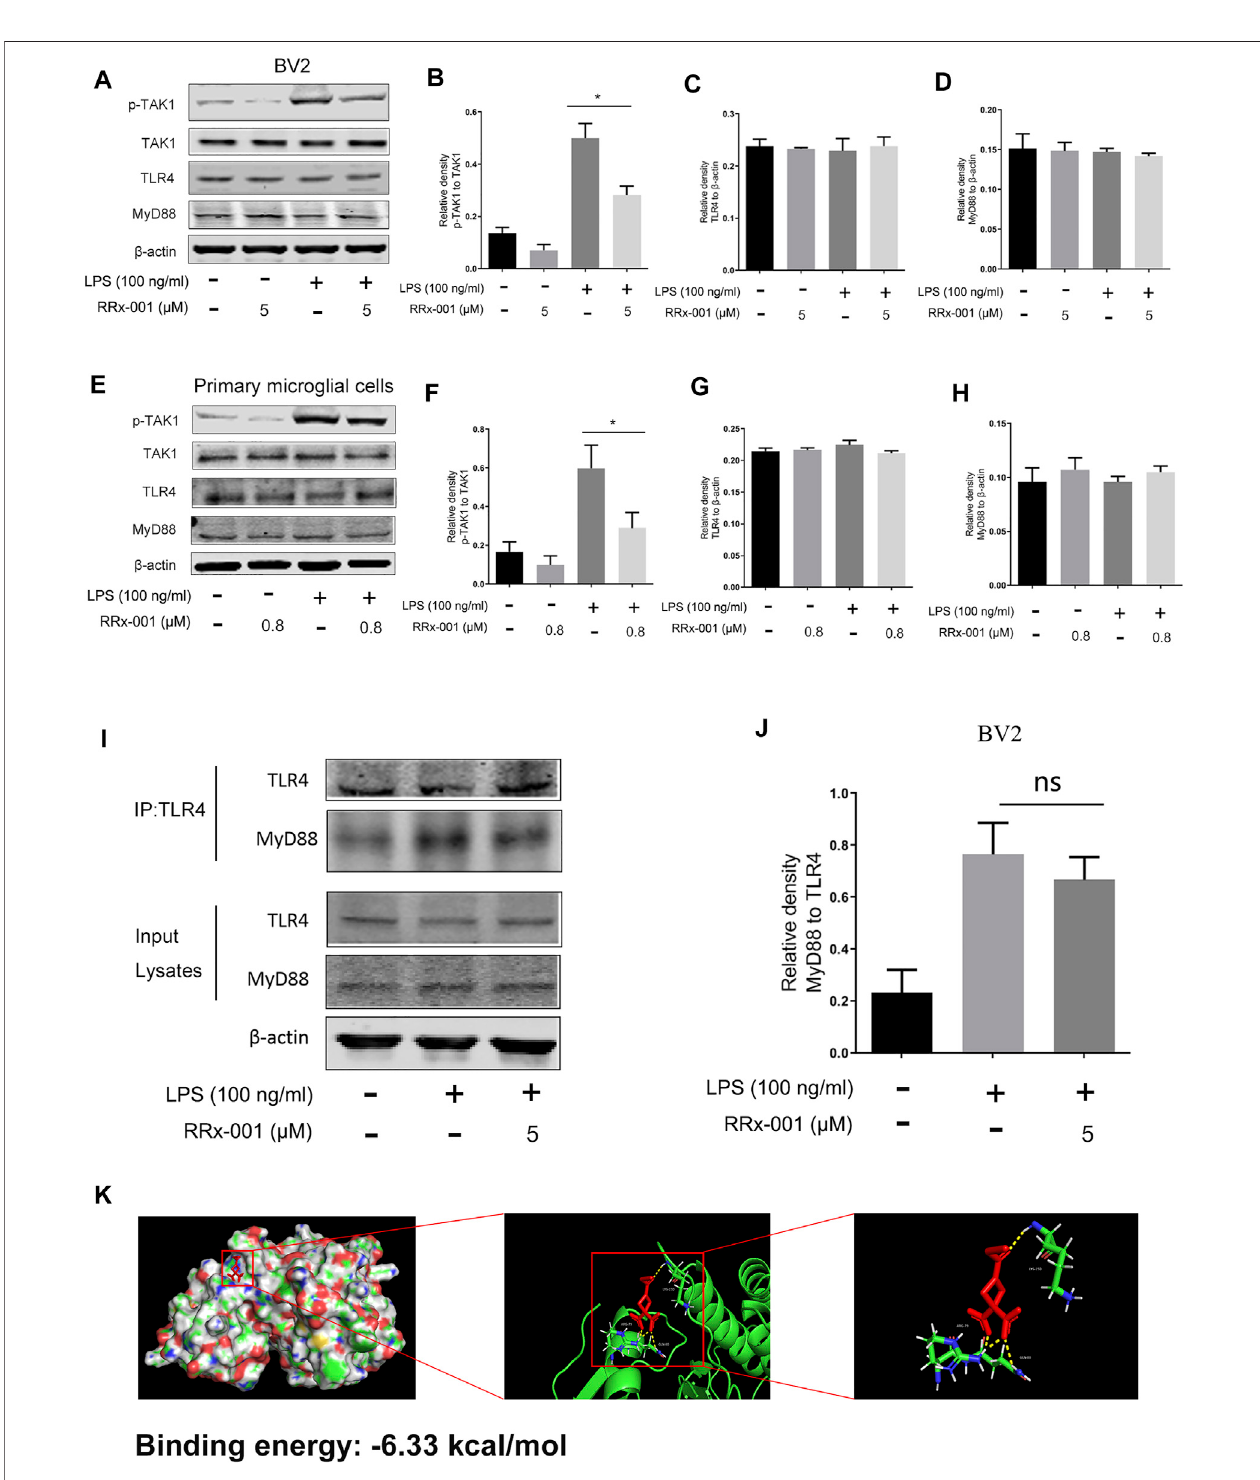
FIGURE 8 | RRx-001 inhibited LPS-induced activation of TAK1, but did not block MyD88 recruitment to TLR4. (A – H) The cells were treated in the same way as in Figure4 .Afterthecellswereharvested,theproteinlevelsofTLR4,MyD88,TAK1,p-TAK1,and β -actinweredetectedusingwesternblottingassay.Therelativeintensity of p-TAK1, TLR4, and MyD88, respectively relative to TAK1 and β -actin was quanti fi ed in the bar fi gures. (I,J) The cells were treated in the same way as in Figure 3C . After the cells were harvested, the proteins were immunoprecipitated with TLR4 using magnetic beads. Immunocomplexes were determined by western blotting assay with anti-TLR4 and anti-MyD88 antibodies, and the relative intensity of MyD88 relative to TLR4 was quanti fi ed. (K) The interaction between RRx-001 and TAK1 wasanalyzedbymoleculardocking.Thevaluesfromthreeindependentexperimentswereshownasthemeans±SEM.One-wayANOVAfollowedbyBonferroni ’ spost- hoc test was used for multiple comparisons between groups, * p < 0.05, compared with those treated with LPS alone.